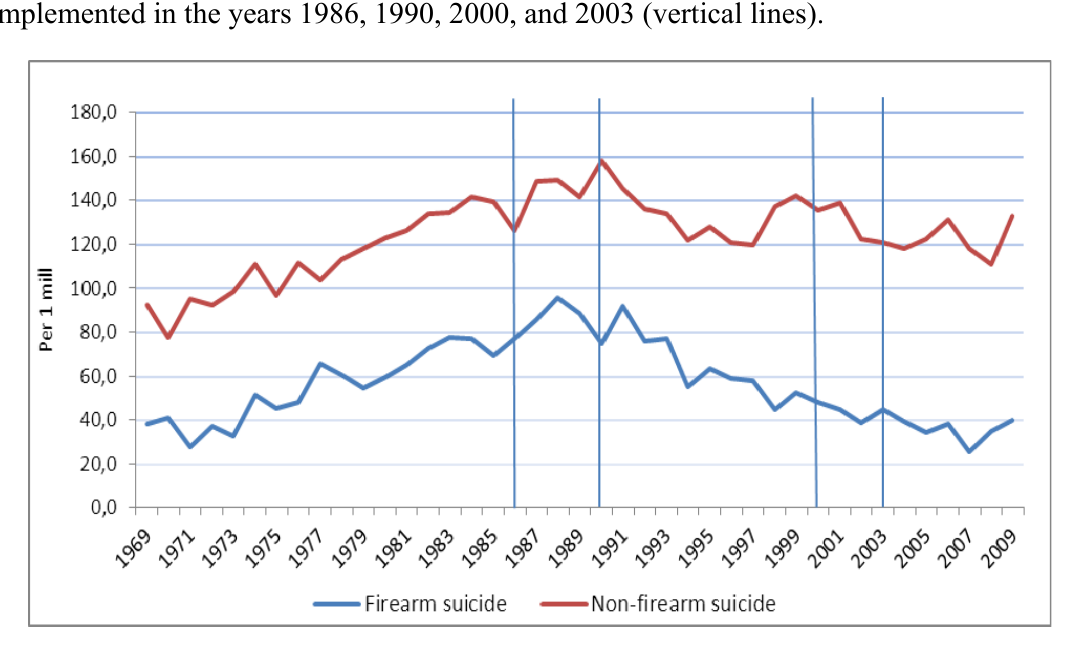
Figure 1. Observed time trends in male firearm suicide and male non-firearm suicide in Norway 1969–2009 (rates per 1 million). Different pieces of firearms legislation were